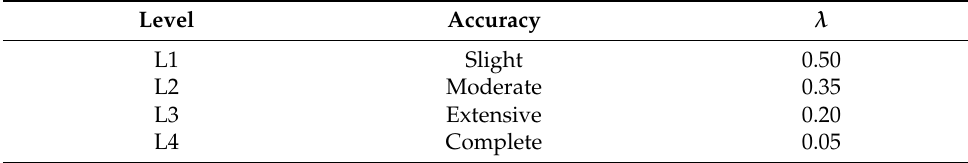
Table 1. Levels of